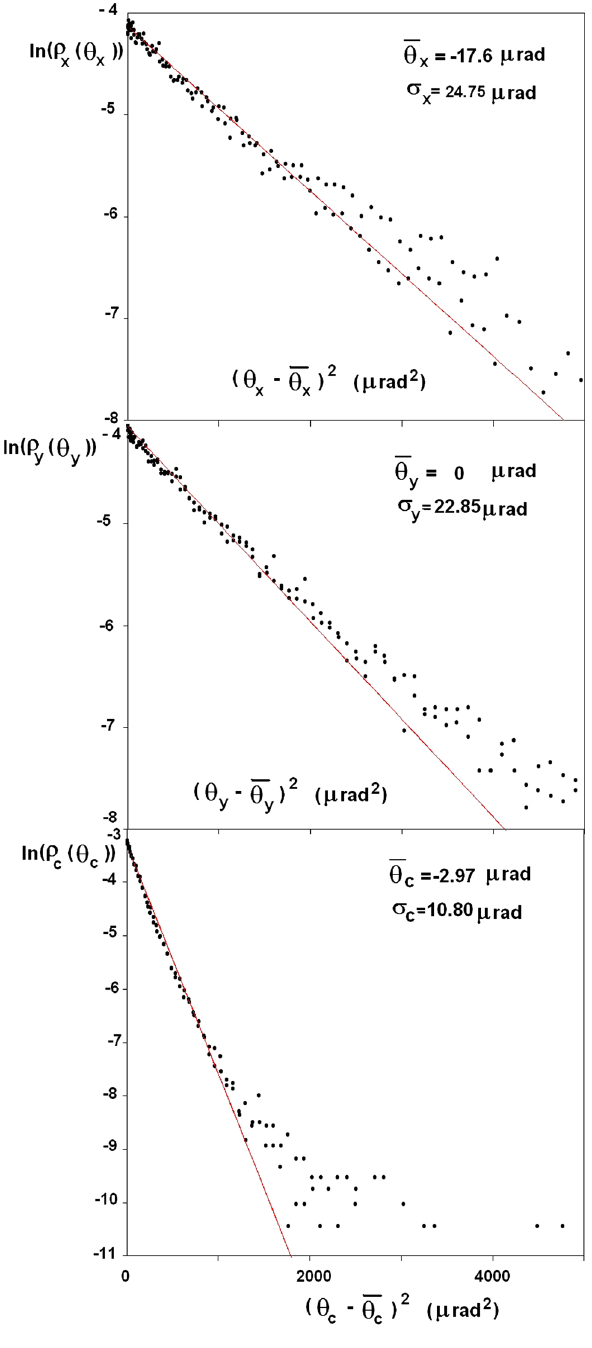
Fig. 3 Experimental angular distributions (for horizontal and vertical non-channeledandverticalchanneledparticles)plottedonalogarithmic scale in accordance with Eq. (2). The straight lines are fits to linear